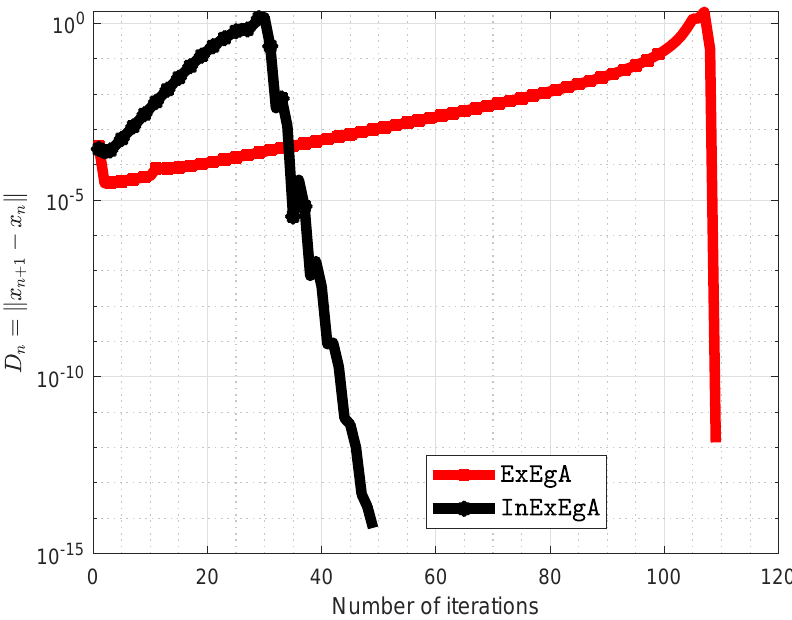
Figure 13. Algorithm1comparisonwithAlgorithm1in[16]andnumberofiterationsare108and49respectively.